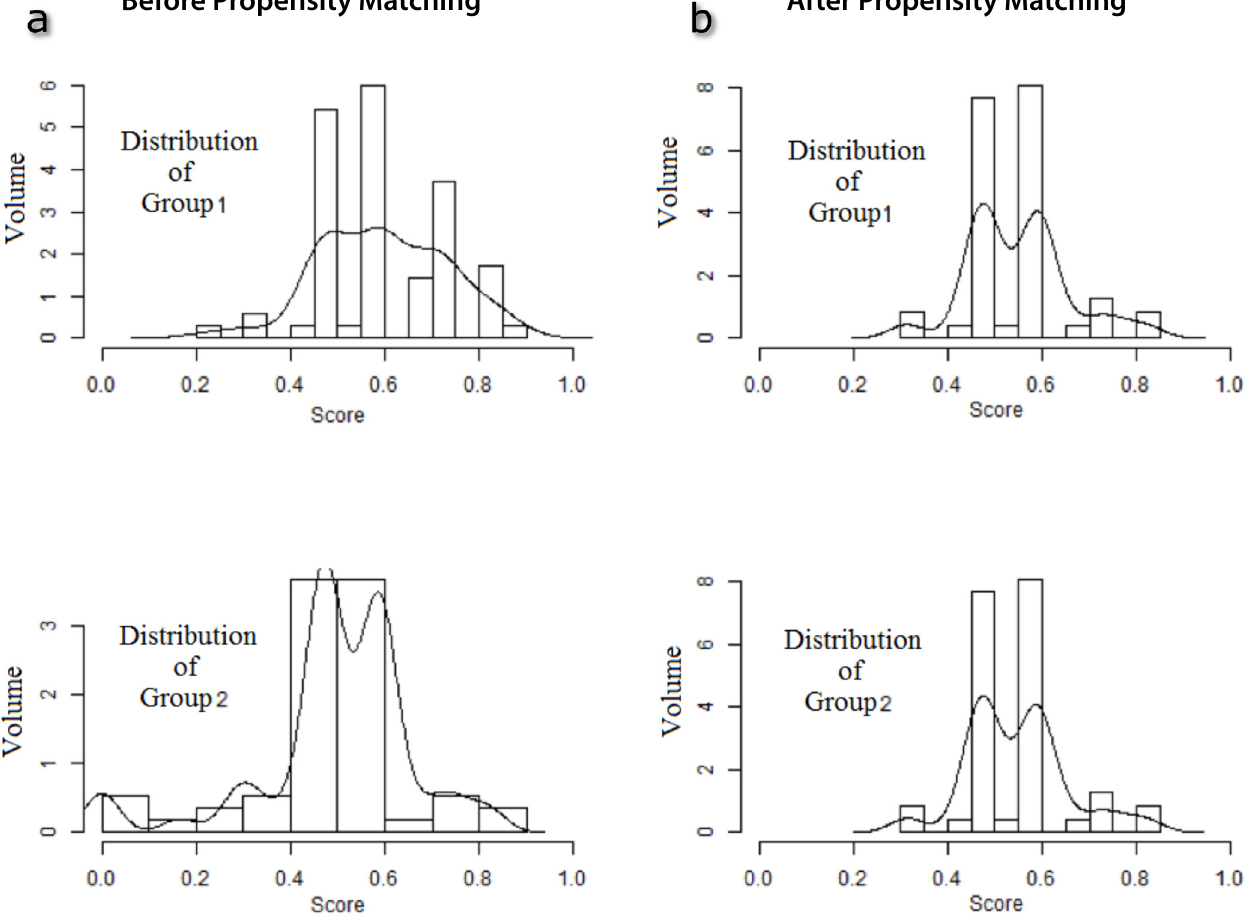
Fig. 3A – Distribution of the groups before the propensity score matching. Fig. 3B – Distribution of the groups after the propensity score